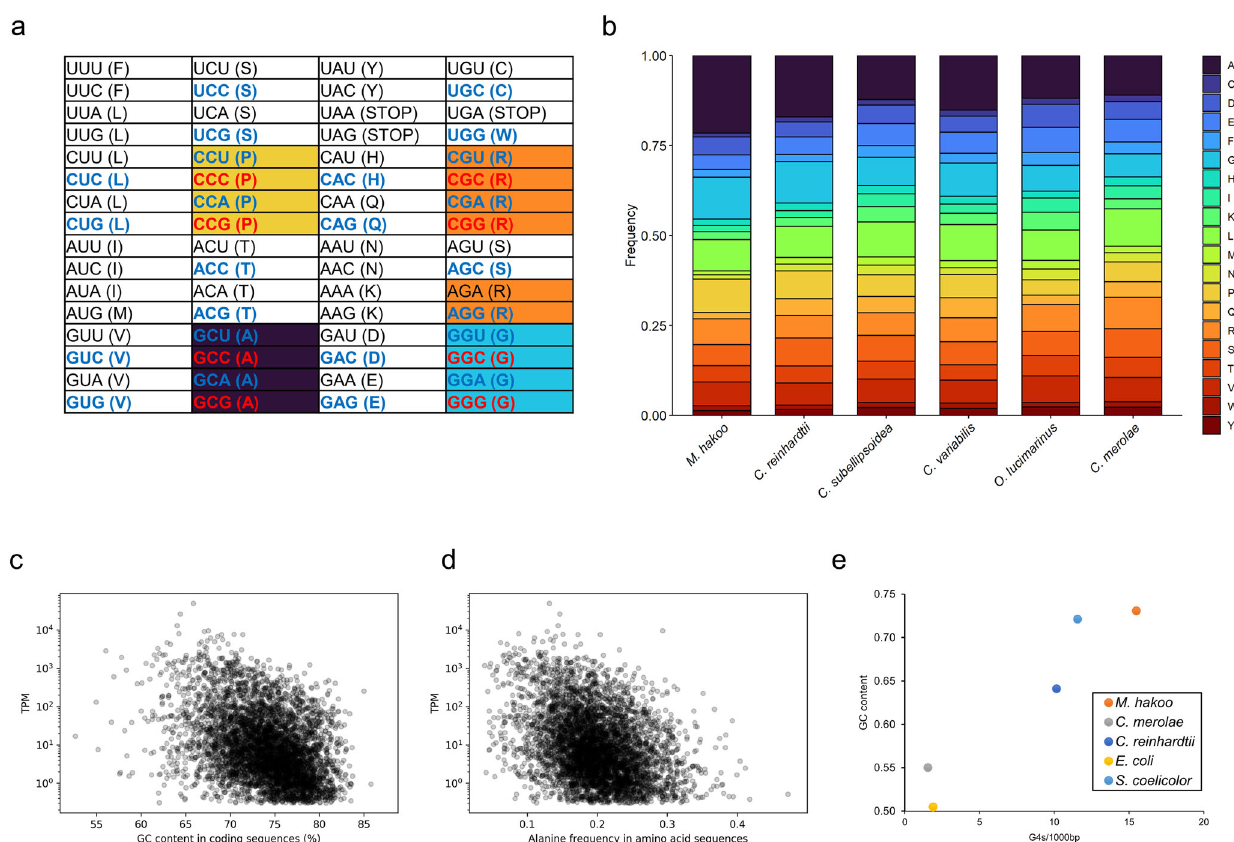
Fig. 3 Effect of a high genomic G + C content. a Codon table. Codons including two G or C are highlighted in blue, whereas those including three G or C are highlighted in red. Alphabets in parentheses indicate single letter designations of amino acids. STOP represents a termination codon. b Amino acid composition in the predicted proteomes of Medakamo hakoo and other microalgae. c Relationship between gene expression and the G + C content of each coding sequence. d Relationship between gene expression and the frequency of alanine in each protein. e Guanine quadruplexes predicted using the pqs fi nder